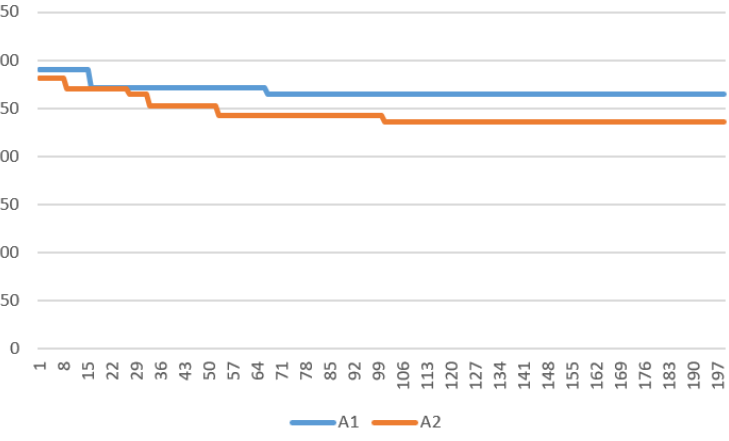
Figure 9. Convergence Diagram of Two Algorithms for Case MK12.